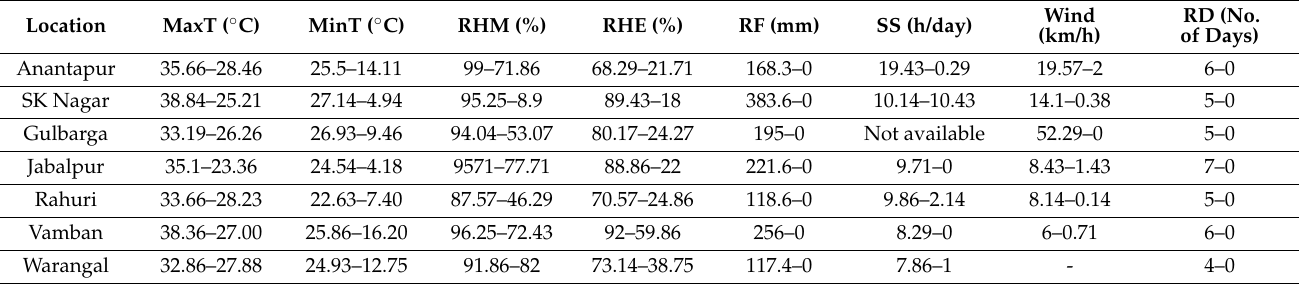
Table 4. Range of weather variables during study seasons.